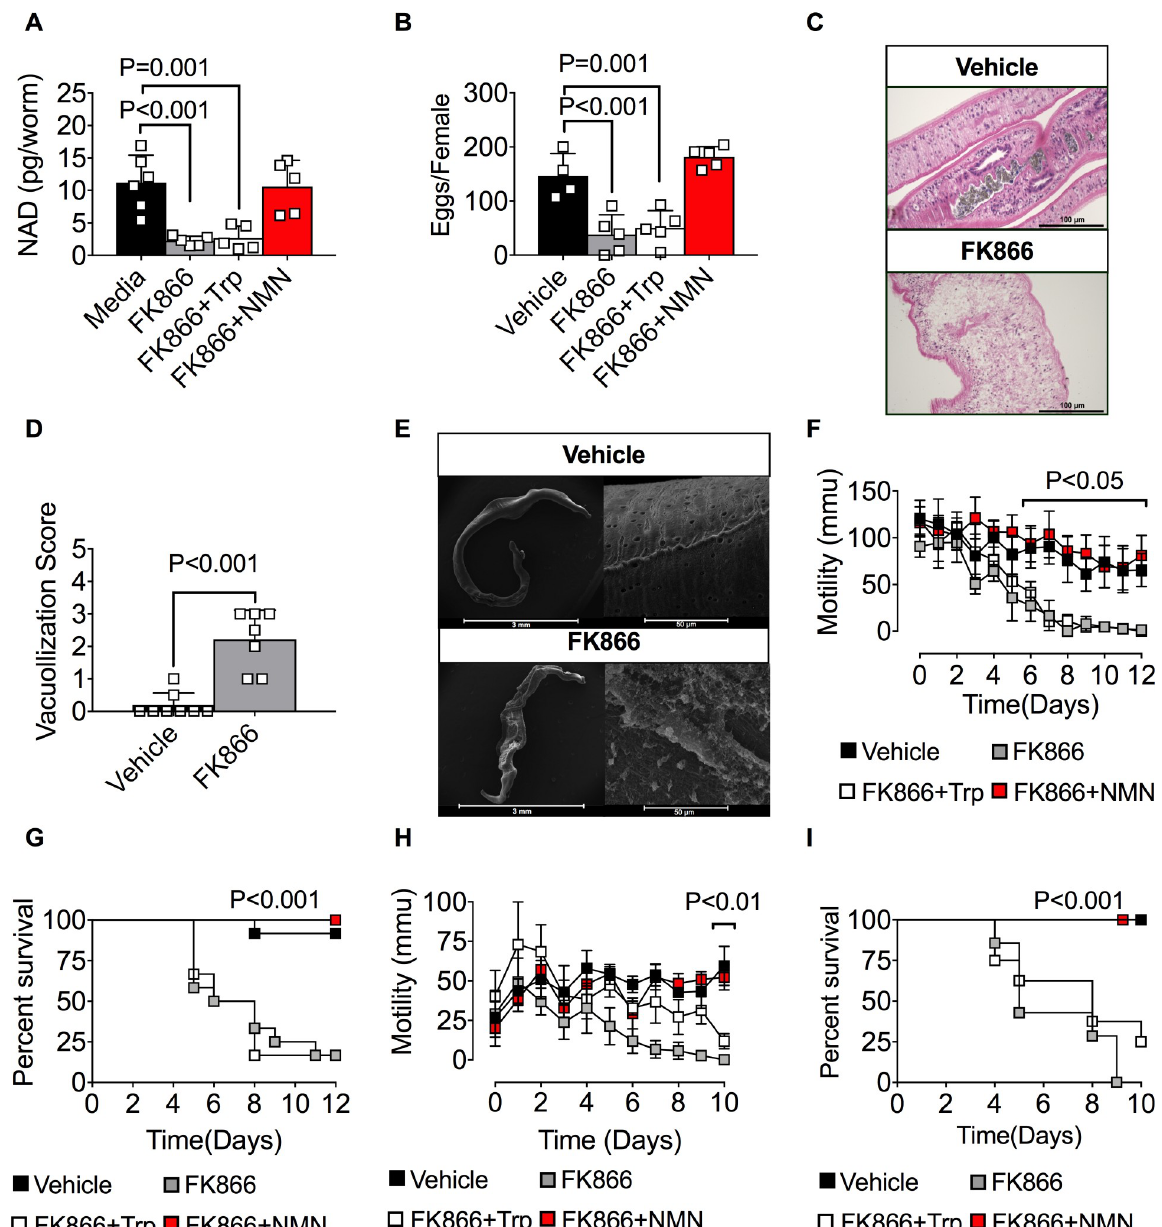
Fig 5. The NAD salvage pathway controls metabolism, and survival of adult and immature S . japonicum . (A) Intracellular NAD levels in female S . japonicum cultured for 48h with vehicle or 250nM FK866 ± 2mM NMN or Trp. n = 5–6 wells/group with 1 female parasite/well. (B) Egg production by female S . japonicum cultured for 48h with vehicle or 250nM FK866 ± 2mM NMN or Trp. n = 4–5 wells/group with 1 female parasite/well. (C-E) Loss of membrane integrity in day 7 FK866-exposed male S . japonicum . Representative H&E stained cross sections (C) and SEM images (E) of male S . japonicum cultured for 7 days with vehicle or 250nM FK866. Severity of tissue damage reported as vacuolization scores (D) as determined by blinded assessment of the H&E cross sections (see S2 Fig for pathology scoring methodology and S3 Fig for additional SEM micrographs). n = 7–10 worms/group/analysis. (F) Parasite mobility by adult S . japonicum cultured for 0–12 days with vehicle or 250nM FK866 ± 2mM NMN or Trp. n = pooled averages from 3 individual experiments consisting of 3 wells/condition with each well containing 2 male and 2 female parasites. (G) Survival of S . japonicum cultured for 12 days with vehicle or 250nM FK866 ± 2mM NMN or Trp. n = 12 parasites (2 males + 2 females/well in triplicate wells). (H) Parasite mobility by S . japonicum schistosomula cultured for 0–10 days with vehicle or 250nM FK866 ± 2mM NMN or Trp. n = 3 wells/group with 6–9 schistosomula/well. (I) Survival of S . japonicum schistosomula cultured for 10 days with vehicle or 250nM FK866 ± 2mM NMN or Trp. Data are shown as the percentage of parasites alive at each timepoint. n = 6–9 parasites/group. Data are representative of 2 (A-E, H-I) or 3 (F-G) independent experiments. Data shown as the mean ± SD (A-B, D, H) or mean ± SEM (F) with individual samples shown in squares. Statistical tests were performed using one-way ANOVA multiple comparison